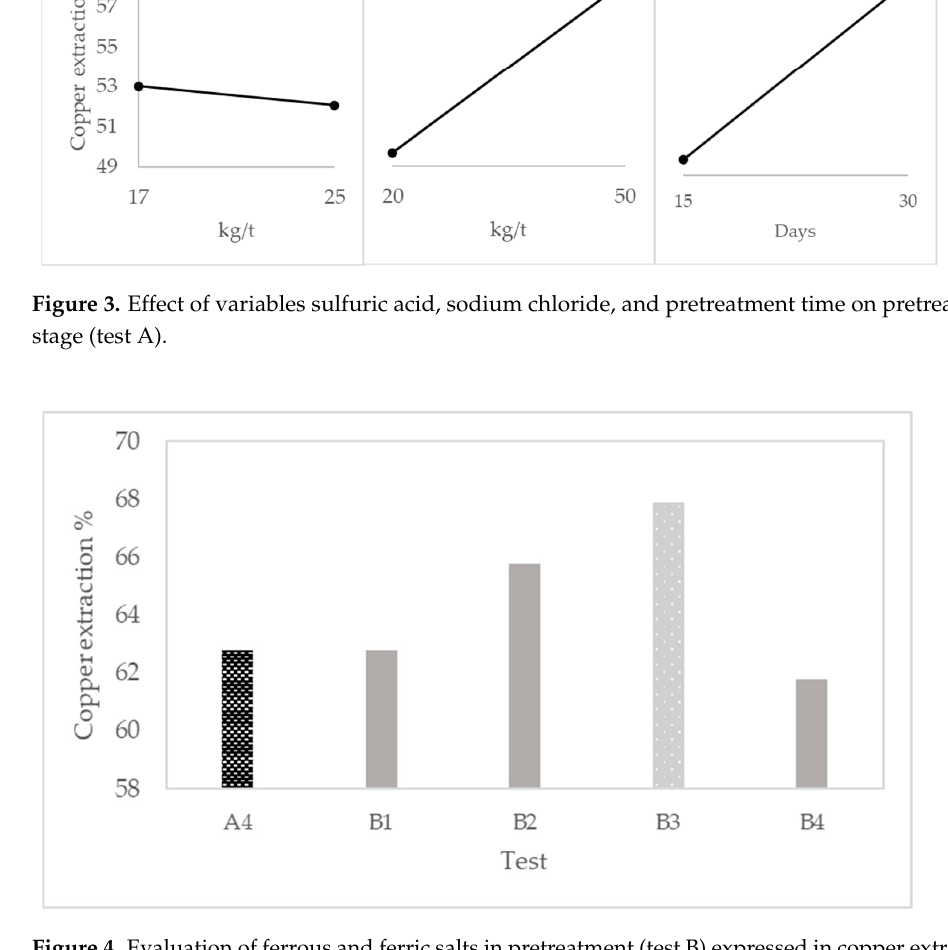
Figure 4. Evaluation of ferrous and ferric salts in pretreatment (test B) expressed in copper extrac- tion.